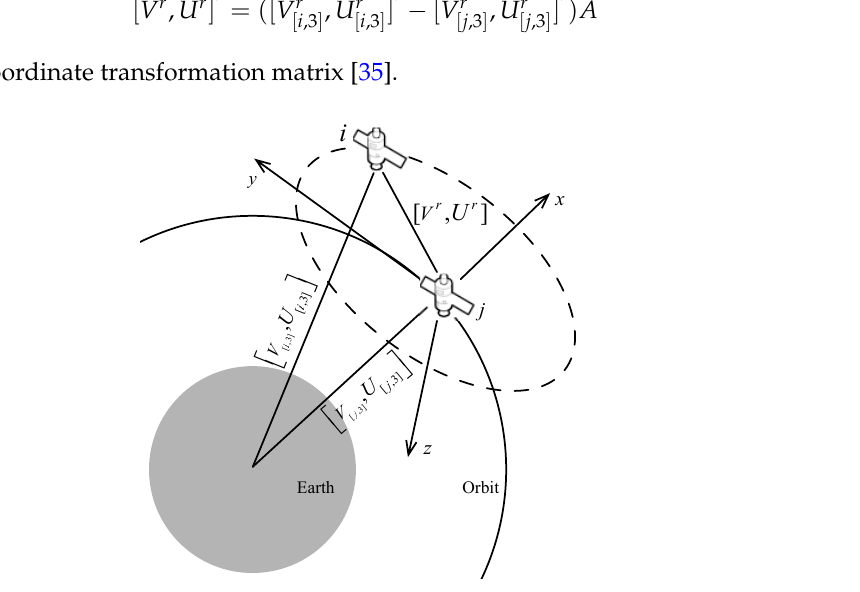
Figure 4. Illustration of transforming position and velocity in ECI to the relative coordinate system of satellite j